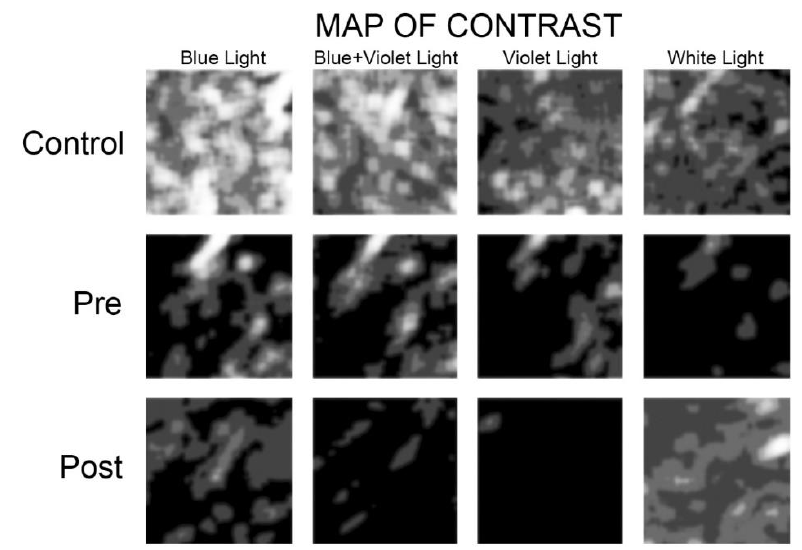
Figure 6. The upper panel consists of photographic images taken intra-orally under blue (450 nm), blue+violet (405 + 460 nm), violet (405 nm), and white light for control mucosa, lichen lesion pre- treatment, and lichen lesion post-treatment. The lower panel shows contrast distribution maps over the surface of the same photographs from the upper panel. White areas indicate areas of locally increased contrast in the image texture. On the contrary, dark areas indicate areas of low contrast (control—healthy mucous, Pre—lesion before treatment, Post—lesion after treatment).